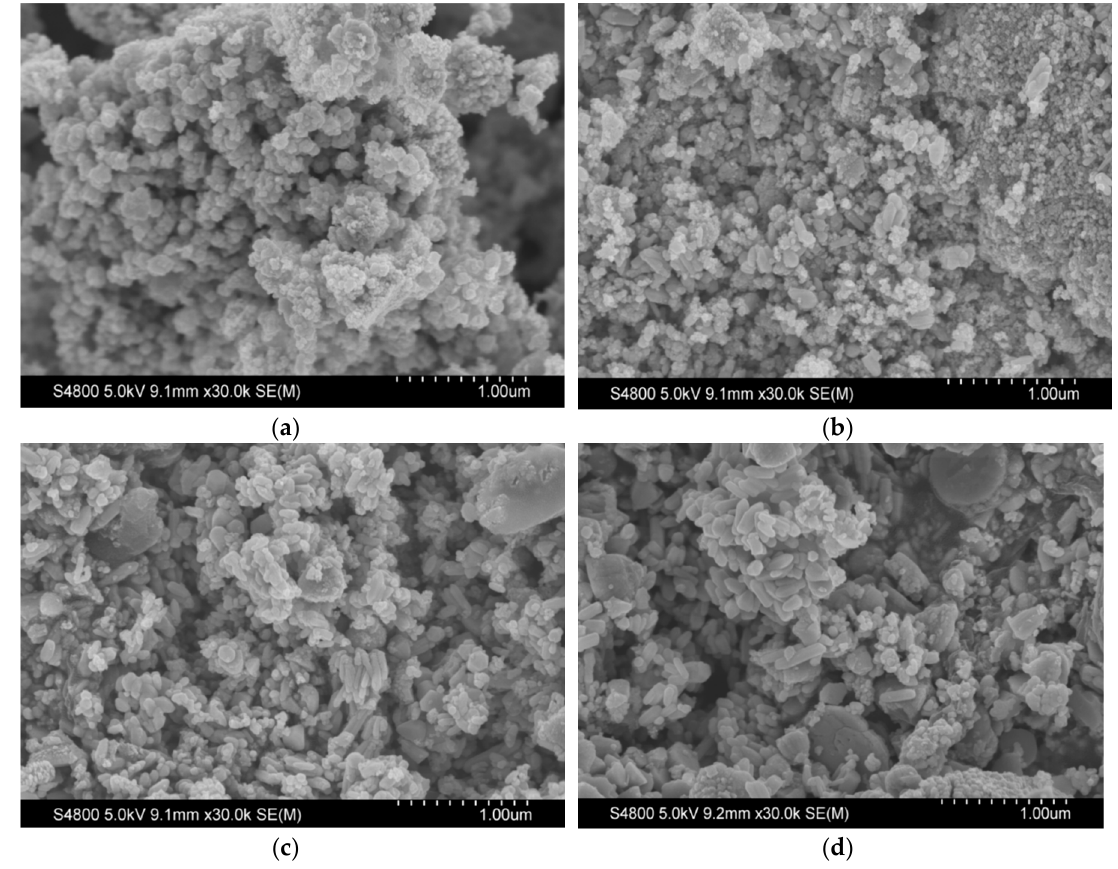
Figure 13. SEM diagrams of four types of Chitin/ZnO: ( a ) Chitin/ZnO = 1:2; ( b ) Chitin/ZnO = 2:3; ( c ) Chitin/ZnO = 1:1; ( d ) Chitin/ZnO = 2:1. Four samples were all calcinated at 500 °C (testing by Hitachi S4800).